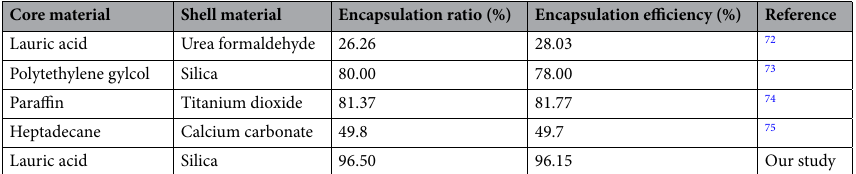
Table 4. Comparison of the encapsulation ratio and efficiency with previous